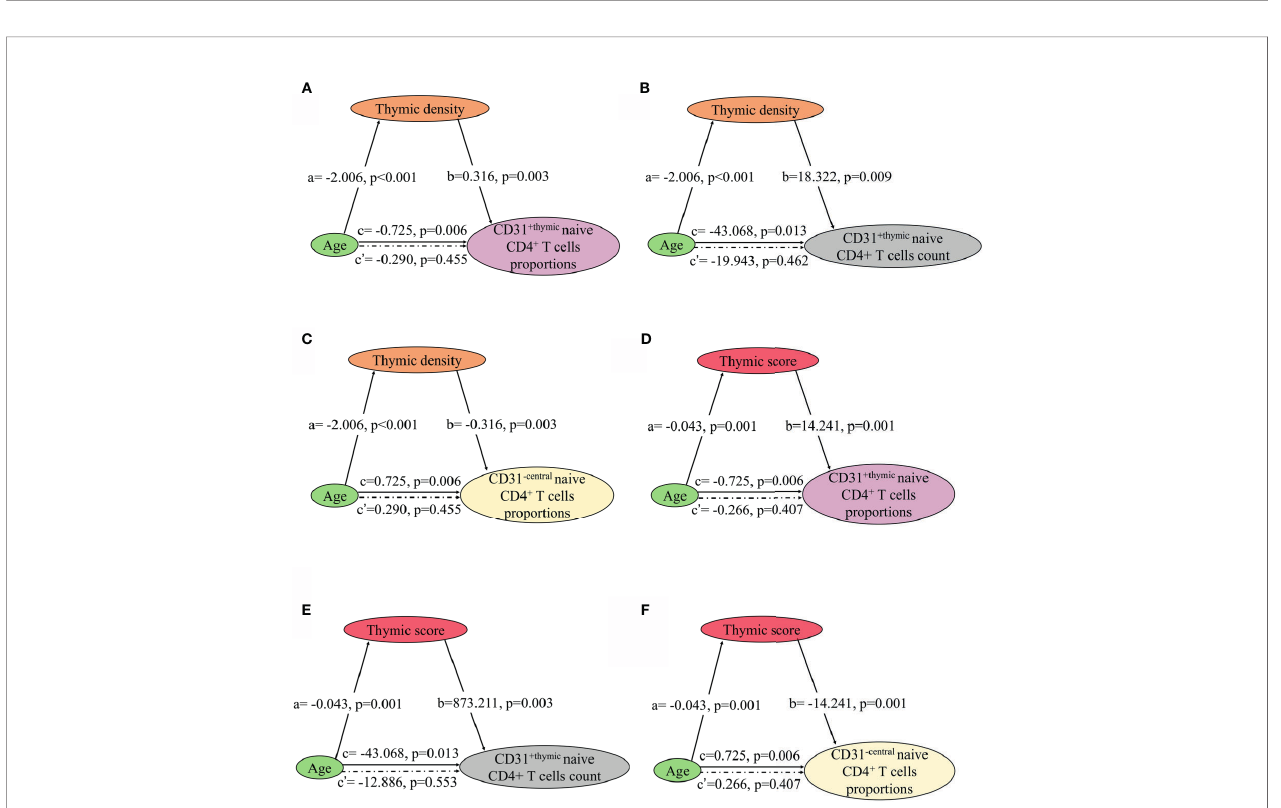
FIGURE 7 | Mediation effects of changes in thymic density and score on the association of decline in NMOSD thymic output naive CD4 T cells with age. (A – C) Mediation analysis was performed to examine the potential indirect relationship between Age (X) and thymic output naive CD4 T cells (Y) via the thymic density (M). (D – F) Mediation analysis the potential indirect relationship between Age (X) and thymic output naive CD4 T cells (Y) via the thymic score (M). Path a and path b indicate the association between X and M, and M and Y, respectively. Path c represents the total effect of X on Y, and path c ’ shows the direct effect of X on Y after controlling for mediating factor. X, predictor variable; Y, outcome variable; M,